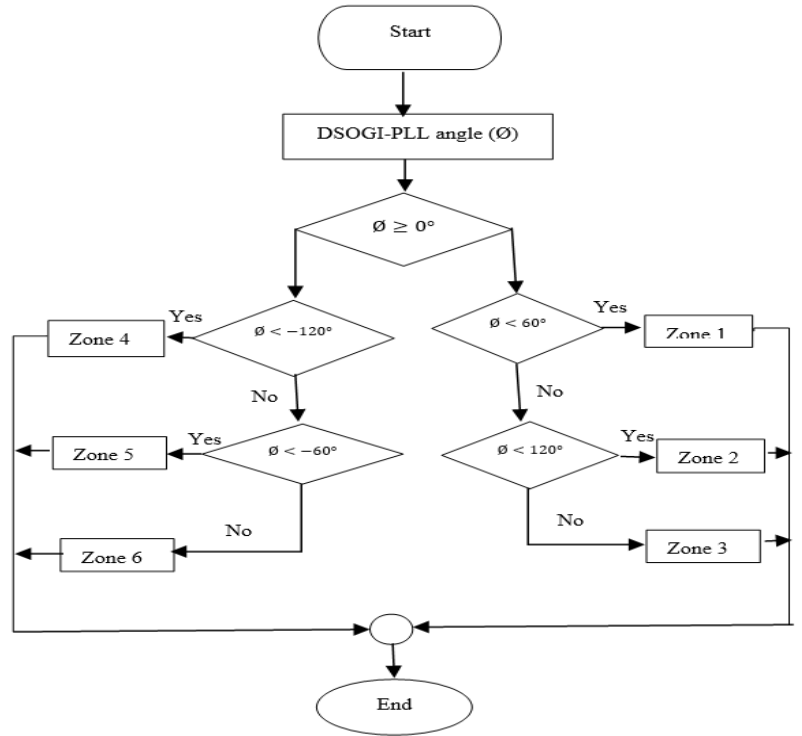
Figure 6. Flow chart of PWM subroutine.